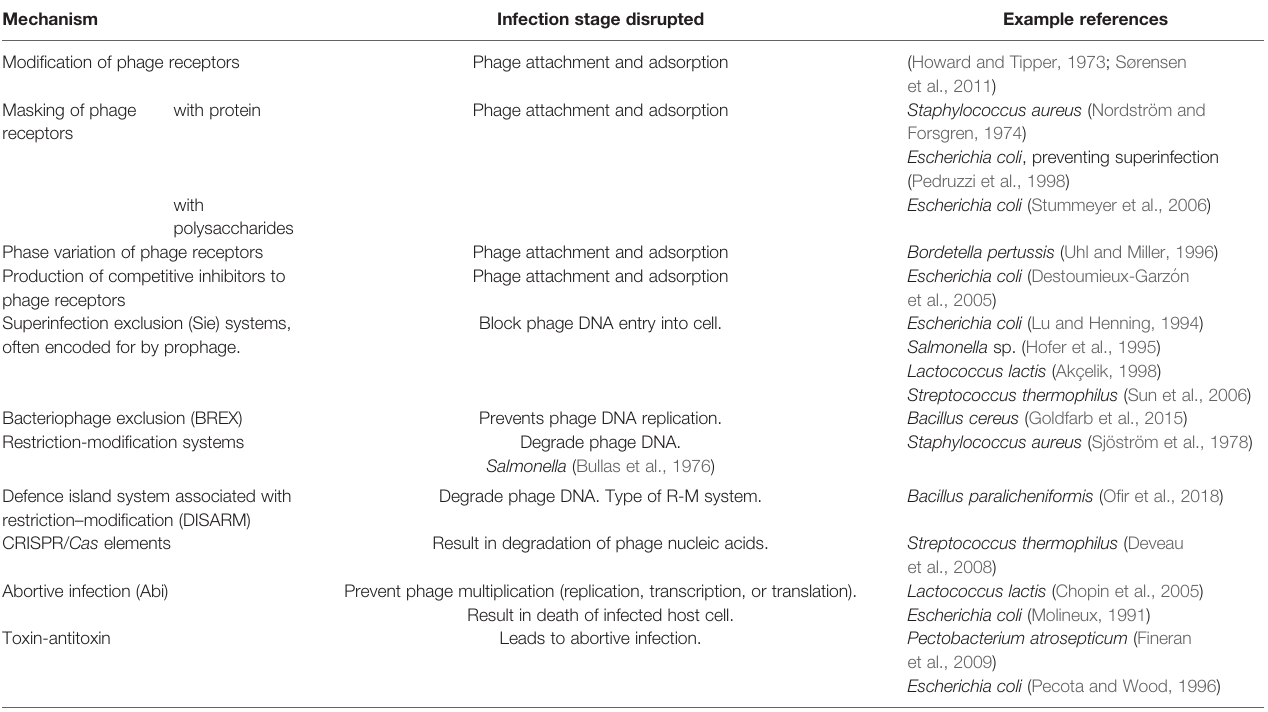
TABLE 5 | Summary of bacteria-encoded phage defence